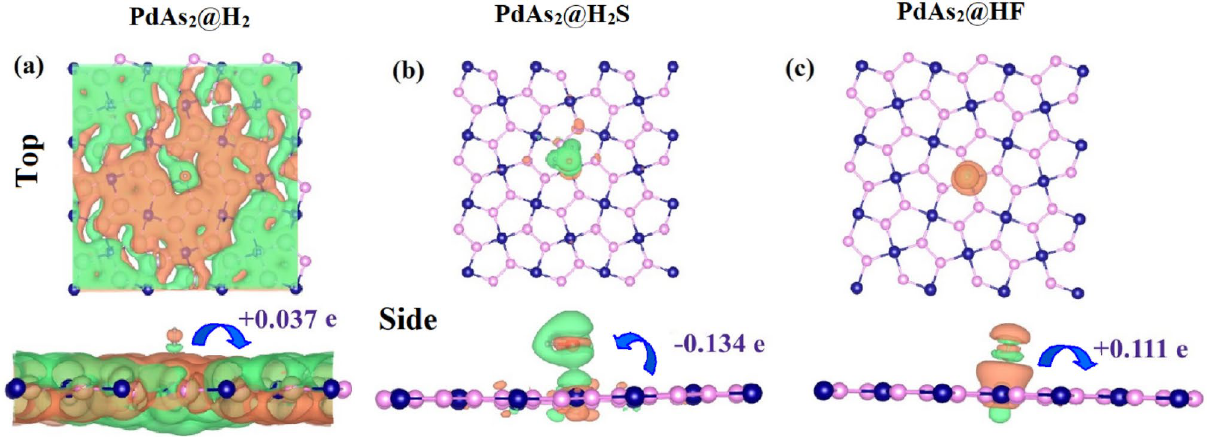
Figure 2. The charge density difference (CDD) and charge transfer of ( a ) H 2 , ( b ) H 2 S and ( c ) HF molecules after absorbed. Green and orange color represent accumulation and depletion of charge, respectively. The isovalue used for plotting is 0.03 e/Å 3 .